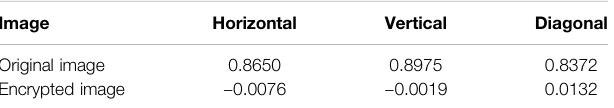
TABLE 4 | Correlation coef fi cient analysis results.